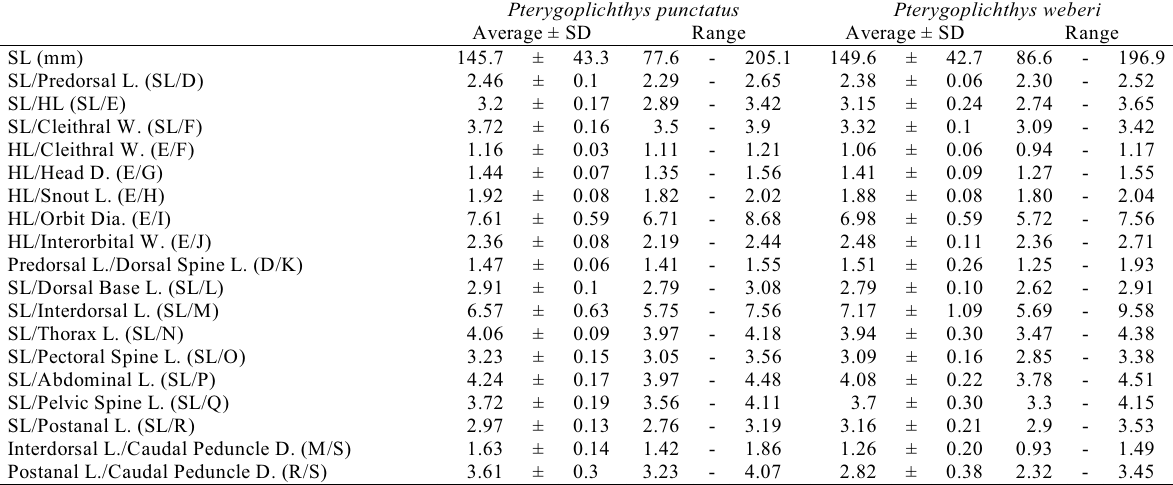
Table 1. Selected morphometrics of Pterygoplichthys punctatus (N=27 except D/K, N=24) and P. weberi (N=11 except D/K, N=7). The letters refer to codes for measurements in Boeseman (1968).